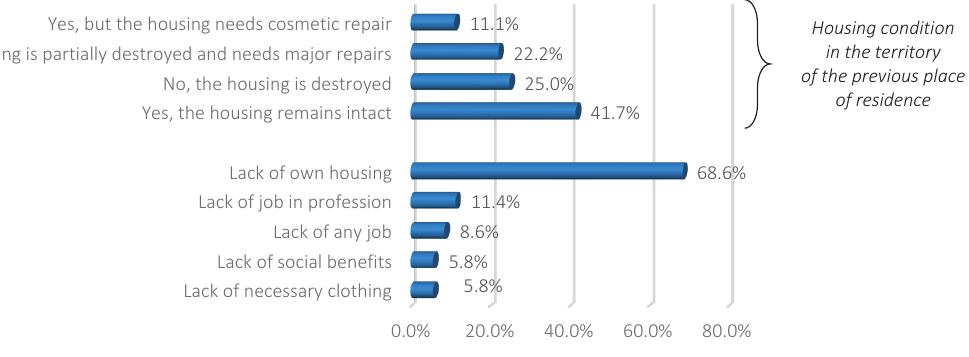
Figure 4. Relevant tangible problems of IDPs in the Pidberiztsivska community, % of